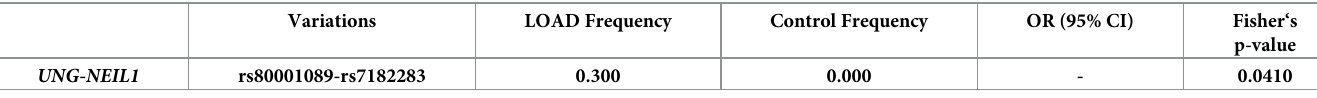
Table 11. Epistatic interaction between UNG and NEIL1 in TC samples.